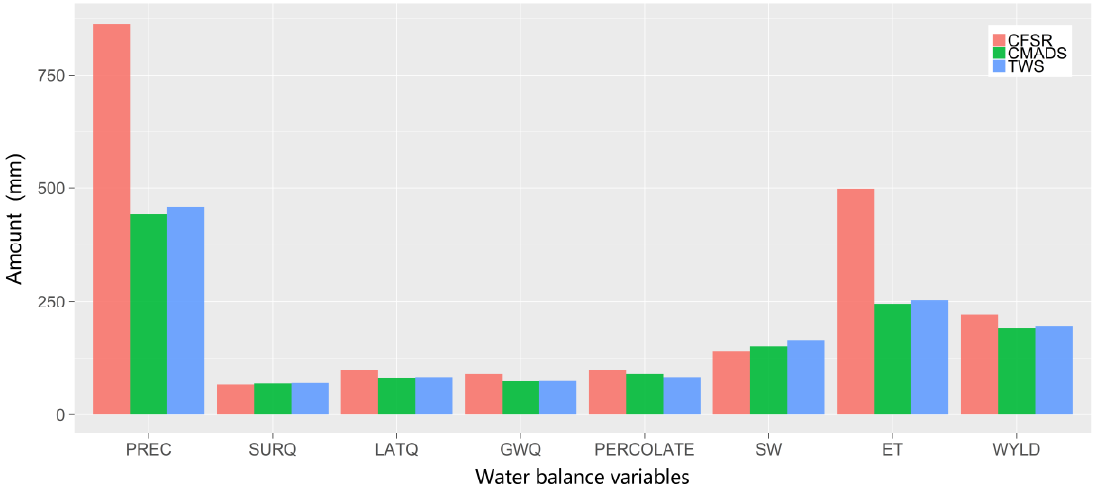
Figure 13. Water balance chart in Heihe River Basin (HRB) for the three modes (TWS + SWAT, CFSR + SWAT, and CMADS + SWAT), where PREC, SURQ, LATQ, GWQ, PERCOLATE, SW, ET, and WYLD represent precipitation, surface runoff, lateral flow, return flow, percolation to shallow aquifer, soil water, evaporation and transpiration, and water yield, respectively.